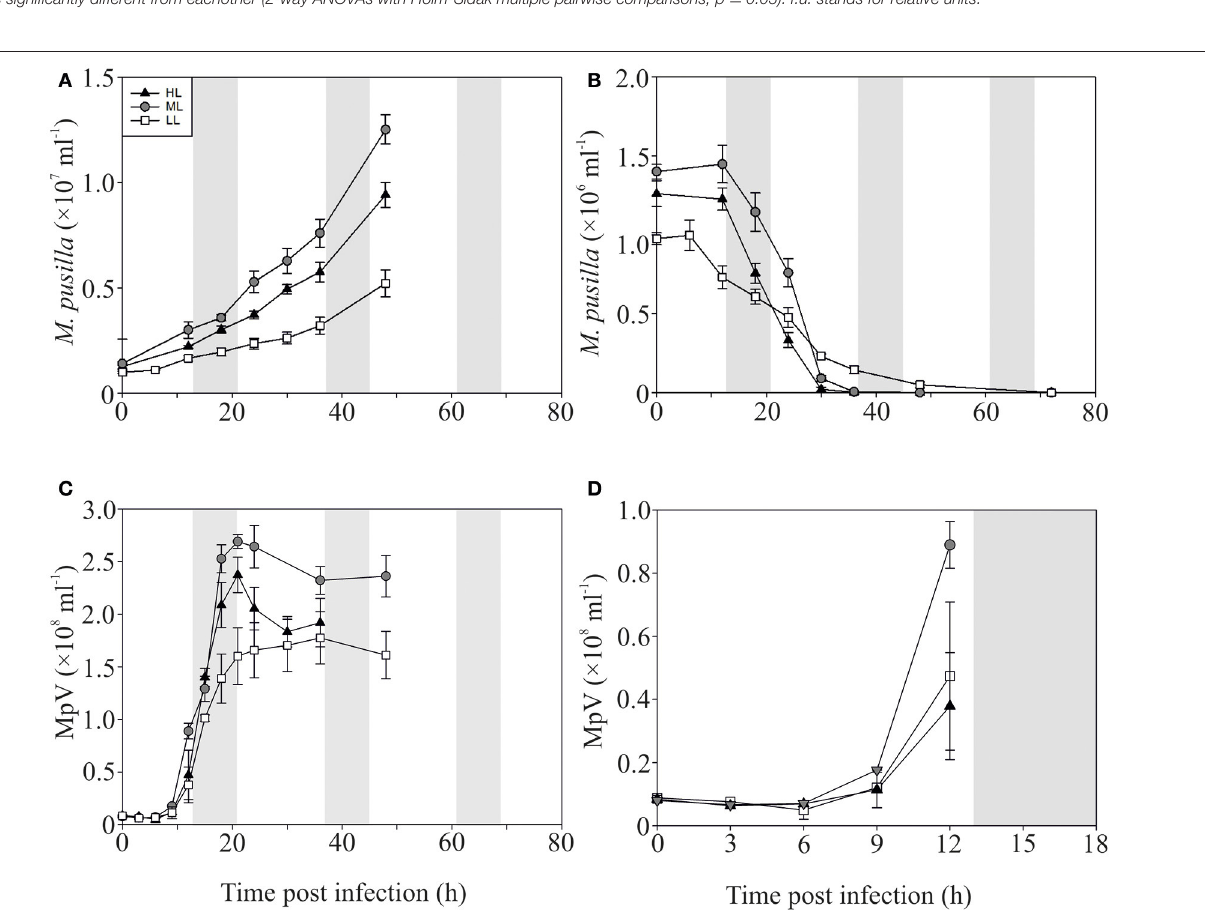
FIGURE 2 | Algal and viral growth curves with abundances of non-infected (A) and infected (B) Micromonas pusilla and MpV (C) under P-replete conditions. (D) Shows MpV abundances in the first 12h in more detail. Light treatments are depicted by triangles (HL), circles (ML), and squares (LL). Values are averages ± s.d. Gray bar depicts dark (night)